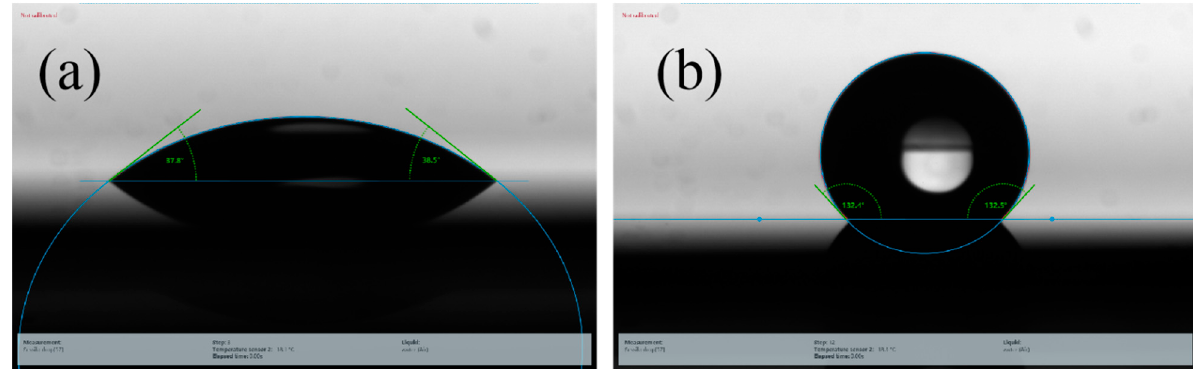
Figure 7. Photographs of the contact angle of a 5-microliter water drop ( a ) on bare silicone, ( b ) on an 8-micrometer inverted pyramidal array after being treated with the MacEtch process for 8 min.